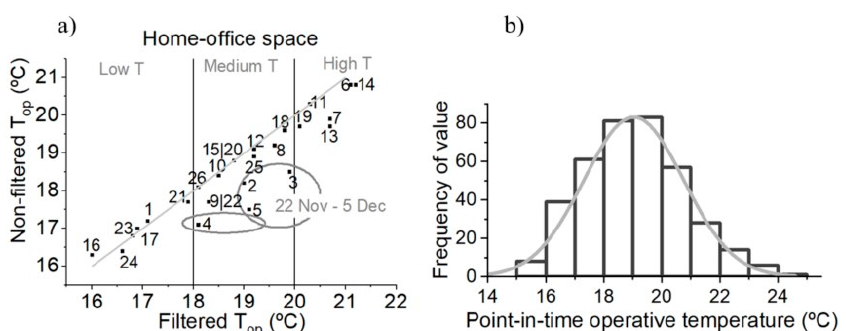
Figure 8. ( a ) Mean temperatures comparing working periods to all periods. Number of household is informed next to each point. ( b ) Distribution plot of temperatures while participants answer the surveys (point-in-time).